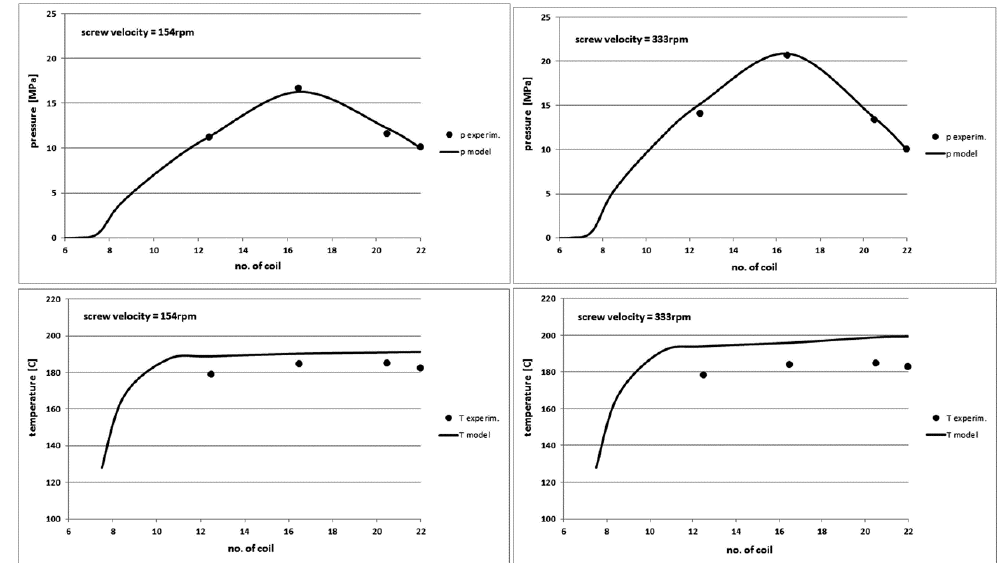
Figure 10. Comparison of theoretical and experimental characteristics of pressure ( top ) and temperature profiles ( bottom ) on the screw channel length in PE-LD injection process for the screw rotation velocity of 154 rpm ( left ) and 333 rpm ( right ).